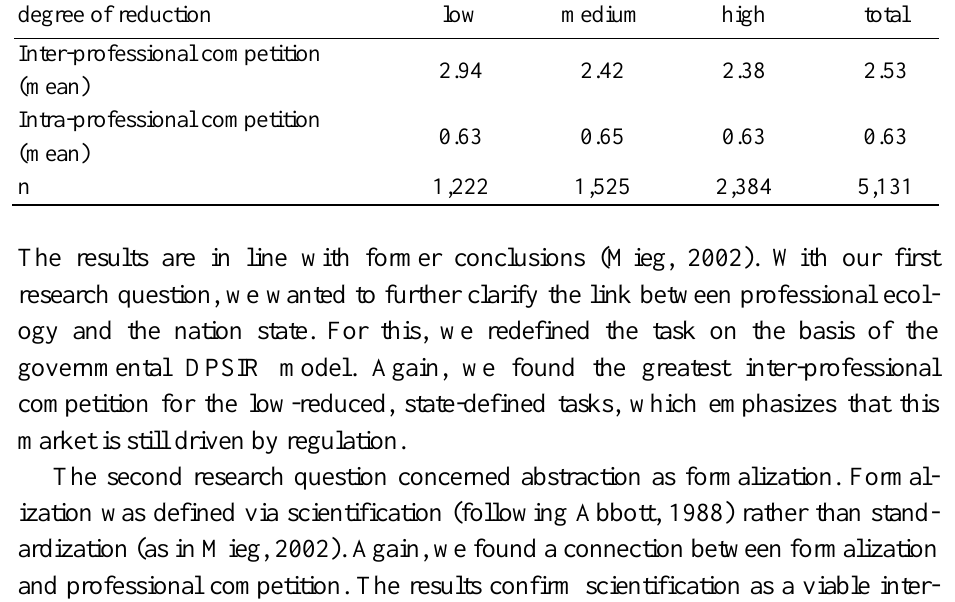
Reduction and professional competition (N = 5,131 tasks) Competition by Degree of reduction degree of reduction low medium high total Inter-professional competition